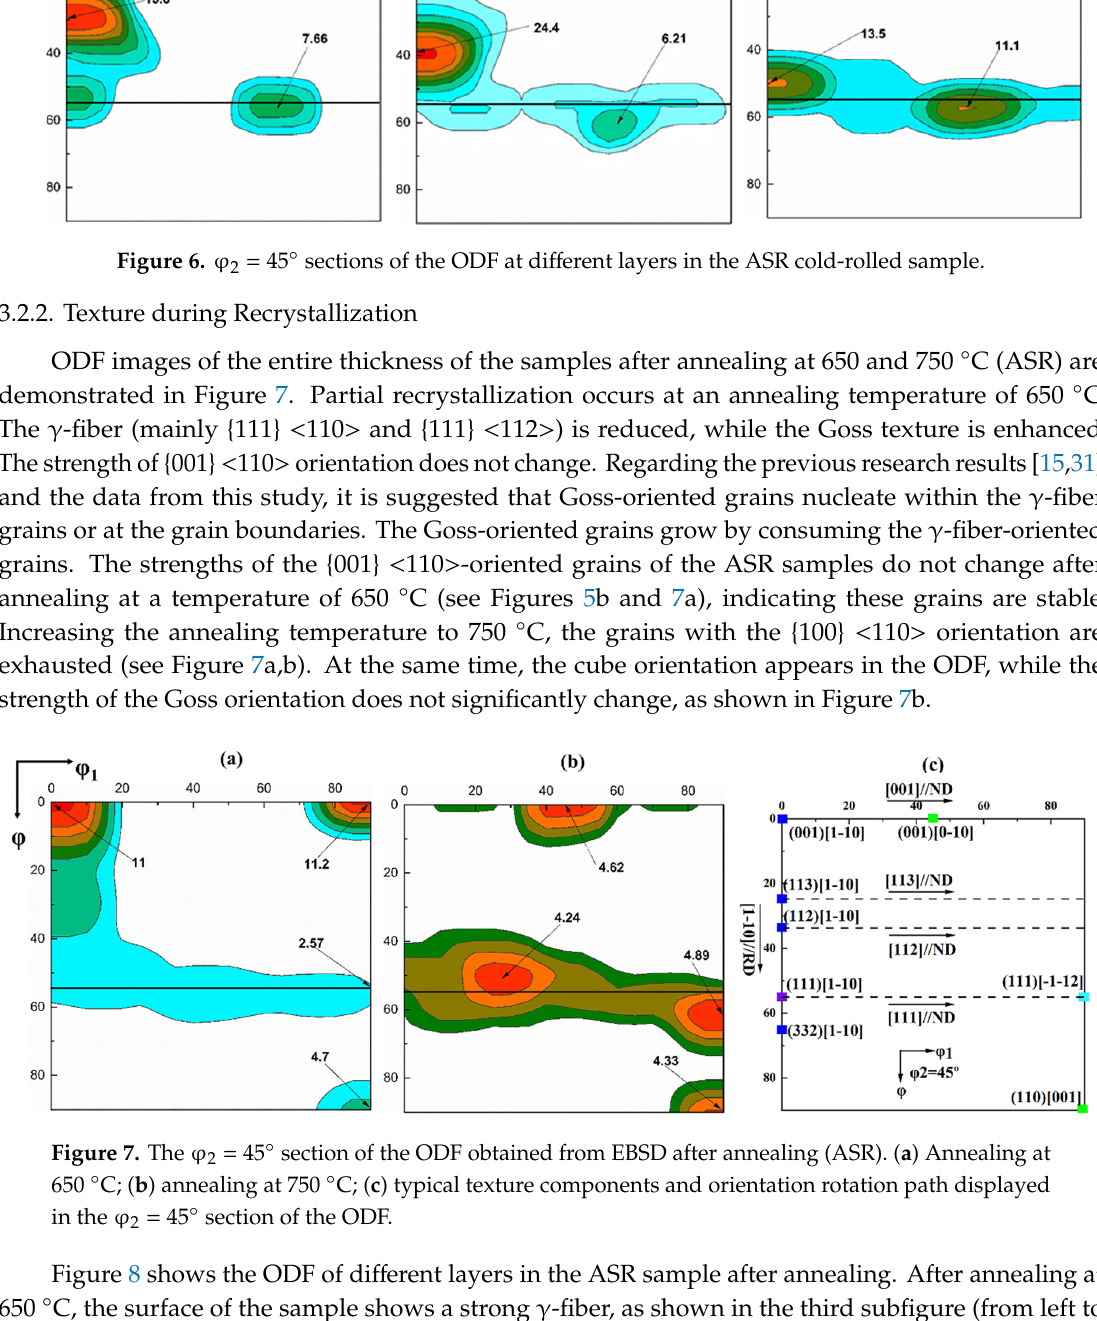
Figure 5. The φ 2 = 45° section of the orientation distribution function (ODF) obtained from electron backscatter diffraction (EBSD) after cold rolling. ( a ) SR; ( b ) ASR; ( c ) typical texture components and orientation rotation path displayed in the φ 2 = 45° section of the ODF.